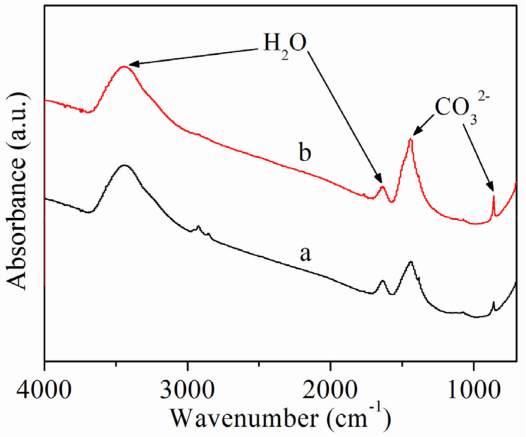
Figure 7. FTIR spectra of 0.04Sr-Ho 2 O 3 -NS (a) and 0.06Sr-Ho 2 O 3 -NS (b) catalysts after the oxidative coupling of methane (OCM) reaction at 600 ◦ C for 1